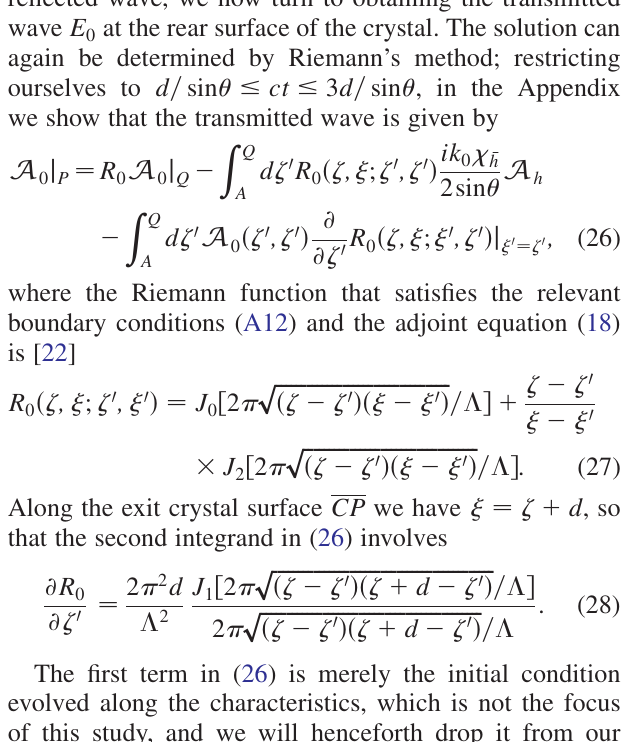
FIG. 3. (a) The temporal power profile (cid:1)j J 1 ð y Þ =y j 2 of the Bragg reflected wave as a function of argument (cid:4)c(cid:1)= ð (cid:2) sin (cid:2) Þ . (b) Reflected field magnitude j E h j from the (004) Bragg reflection of diamond at an incidence angle (cid:2) ¼ 56 : 86 (cid:10) when the incident wave has ¼ 10 (cid:11) m . The wave is displaced transversely to the optical axis by an amount proportional to the time elapsed, with x (cid:6) x